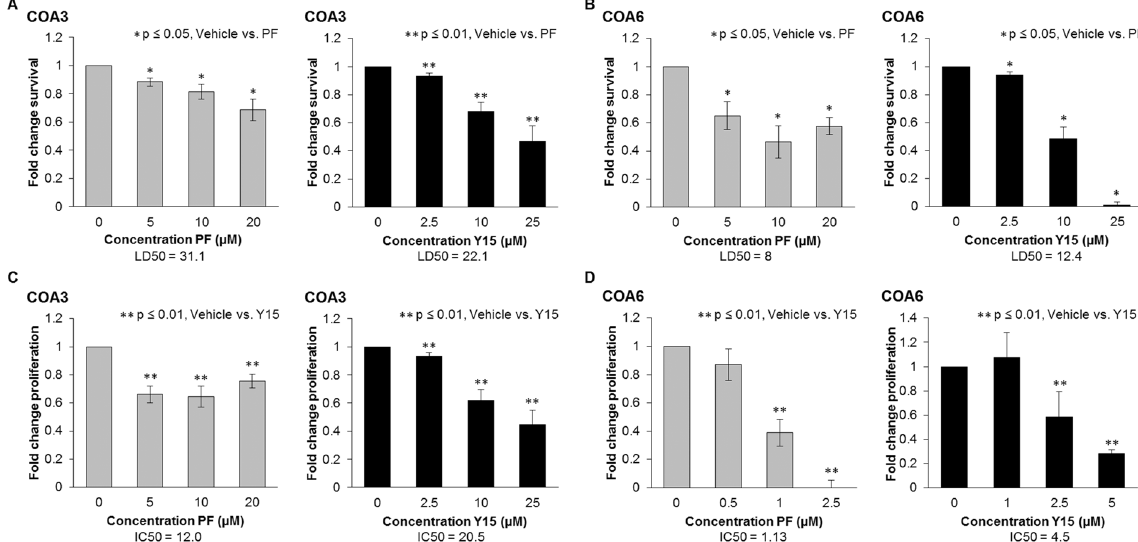
Figure 2. FAK inhibition with PF and Y15 decreased COA3 and COA6 cell survival and proliferation. ( A ) COA3 cells (1.5 × 10 4 ) were treated with increasing concentrations of PF (0, 5, 10, 20 μ M) or Y15 (0, 2.5, 10, 25 μ M) for 24 hours and cell survival was measured using alamarBlue ® assay. There was a significant decrease in cell survival following treatment with PF and Y15, with LD 50 of 31.1 and 22.1 μ M respectively. ( B ) COA6 cells (1.5 × 10 4 ) were treated in the same fashion, and there was a significant decrease in cell survival following treatment with PF and Y15, with LD 50 of 8.0 and 12.4 μ M respectively. ( C ) COA3 cells (5 × 10 3 ) were treated with increasing concentrations of PF (0, 5, 10, 20 μ M) or Y15 (0, 2.5, 10, 25 μ M) for 24 hours and cell proliferation was measured using CellTiter96 assay ® . Proliferation was significantly decreased following treatment with PF and Y15, with IC 50 of 12.0 and 20.5 μ M respectively. ( D ) COA6 cells (5 × 10 3 ) were treated with lower doses of PF (0, 0.5, 1, 2.5 μ M) and Y15 (0, 1, 2.5, 5 μ M) due to increased sensitivity. Proliferation